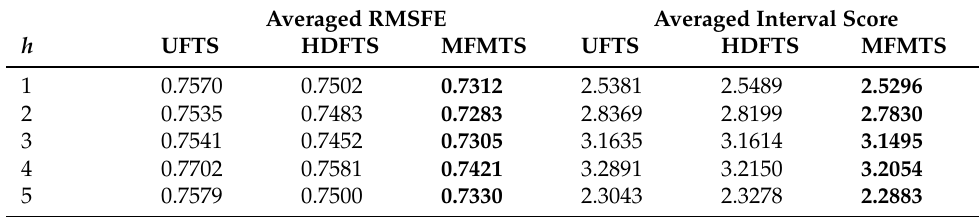
Table 2. Average RMSFE and interval scores. Averaged RMSFE Averaged Interval